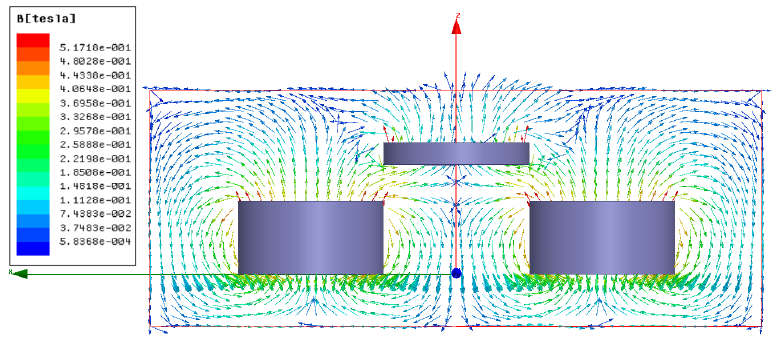
Figure 6. Measurement system magnetic